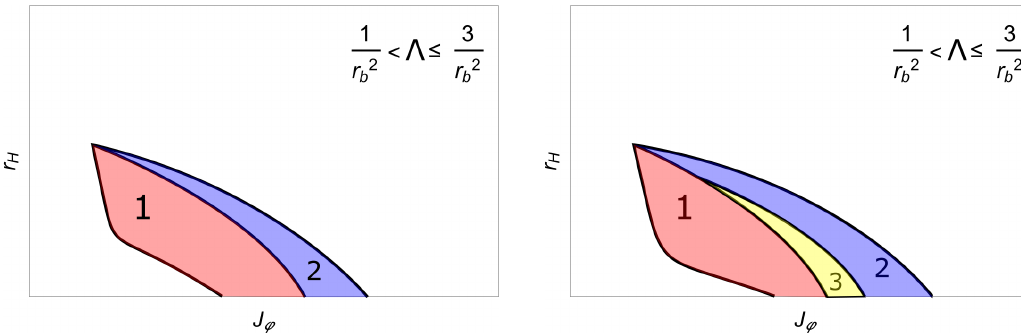
plane of Euclidean PL-soliton Figure 17 . Examples of the structure of existence region on J ϕ − r H ( c ) and PL-BH when 1 . Note that this structure is below r = r line, i.e., there are no < Λ ≤ 3 H b r 2 r 2 b b PL-BG instanton solutions. ( Left ) Simple structure which may appear when both | Λ | /M 2 and r b M are large enough. ( Right ) Complicated structure which appear when the condition does not hold. √ √ (Examples of parameters that exhibit these structures are ( r Λ , M ) = (5 G, 0 . 044 /G, 0 . 1 / G ) b , √ √ ( Left ) and ( r Λ , M ) = (5 G, 0 . 044 /G, 0 . 5 / G ) ( Right b ,